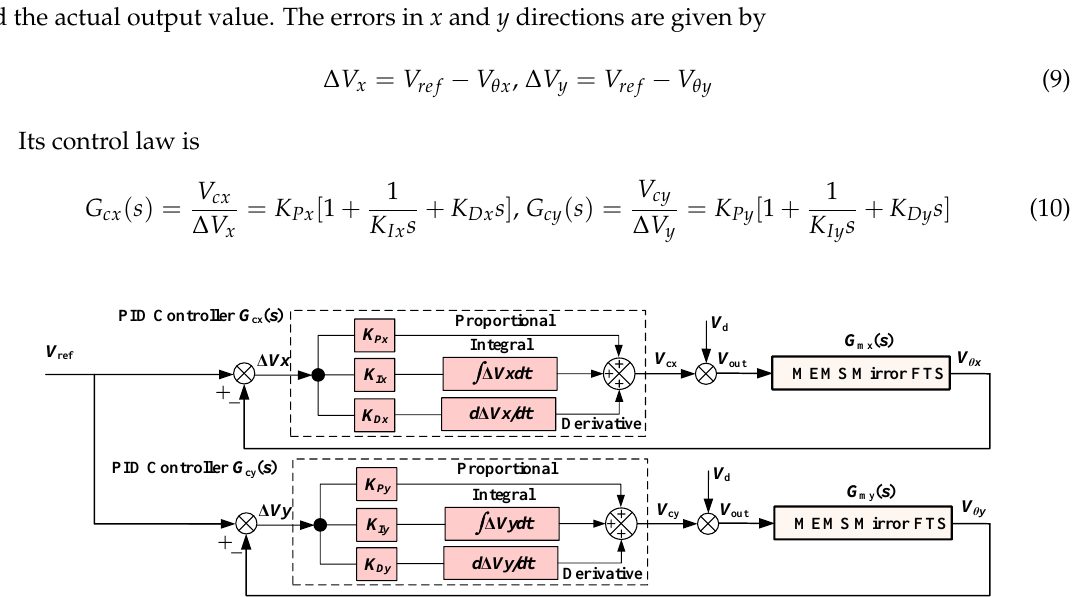
Figure 9. S/T curve. ( a ) S/T curve of X direction; ( b ) S/T curve of Y direction.